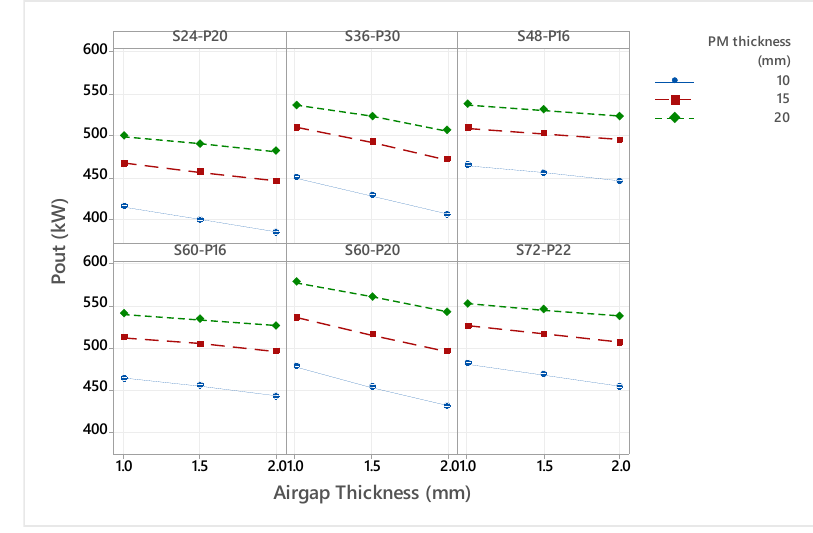
Figure 5. Output (kW) for the PM-to-airgap ratio study.